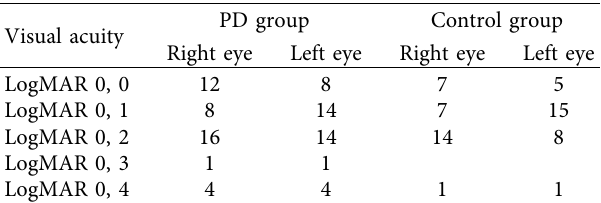
Table 2: LogMAR visual acuity values of PD and control groups.